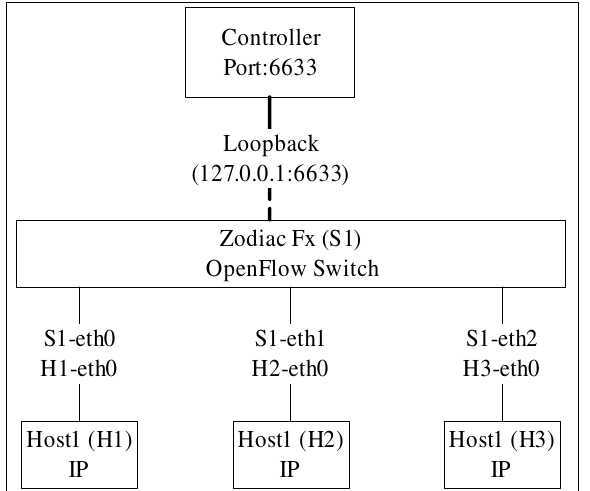
Figure 9. FX connection with Ryu